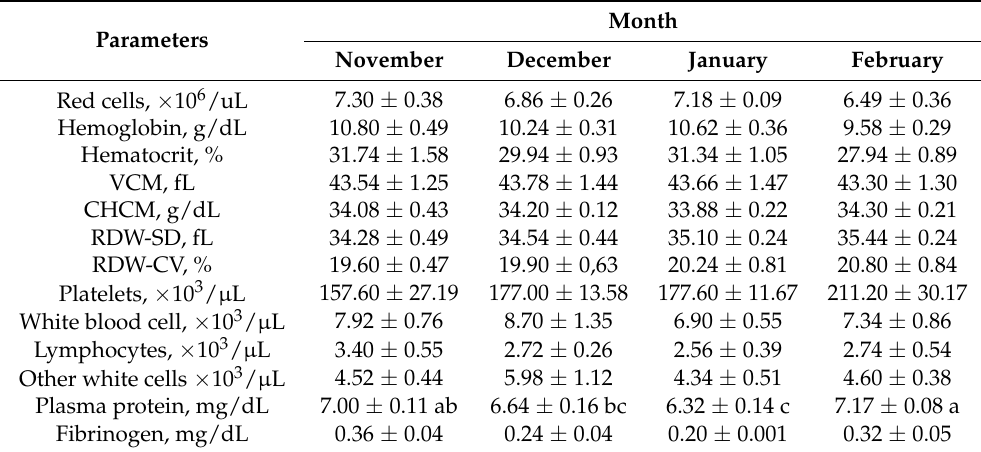
Table 1. Results of blood and biochemical analyses in experimental horses between November and February.